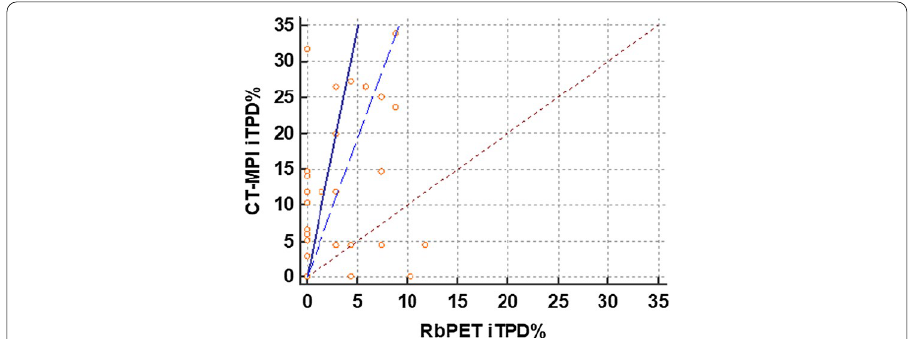
semi-quantitative visual methods of myocardial perfusion assessment (slope 6.86, y-intercept 0, n 43). = = = The blue solid line indicates the slope of CT-MPI iTPD% measurements plotted against the perfect-fit line (dotted red line, slope 1). The dotted blue line shows the lower limit of the 95% CI which does not include = the perfect-fit line and hence, the proportional bias. The proportional bias indicates that the CT-MPI derived iTPD% overestimation of 82 Rb PET derived iTPD% progressively increases with an increase in perfusion abnormalities as identified by 82 Rb PET. The CUSUM (cumulative summation) test shows that the observed data does not significantly deviate from a linear model ( P 0.53). CT-MPI computed tomography myocardial = perfusion imaging; 82 Rb PET 82-Rubidium positron emission tomography; iTPD% ischemic total perfusion deficit % based on visual